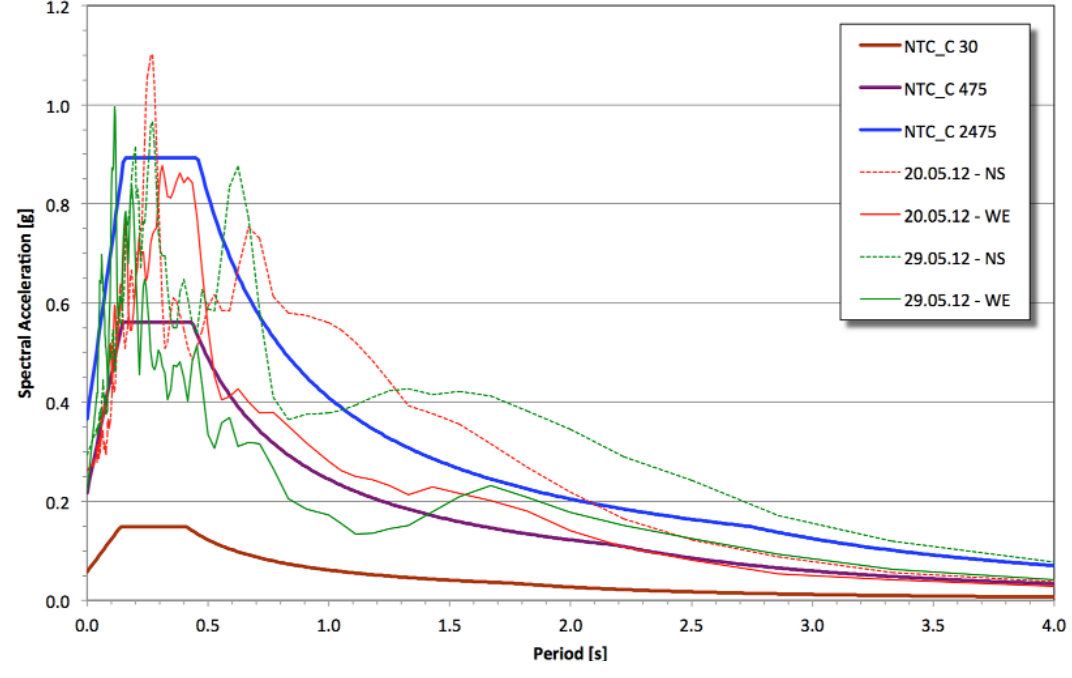
Figure 7. Comparison between the horizontal acceleration response spectra recorded at the MRN station for the two main events of the Emilia sequence, and the design code spectra prescribed by NTC08, for soil type C, for 30, 475 and 2475-year return periods (as